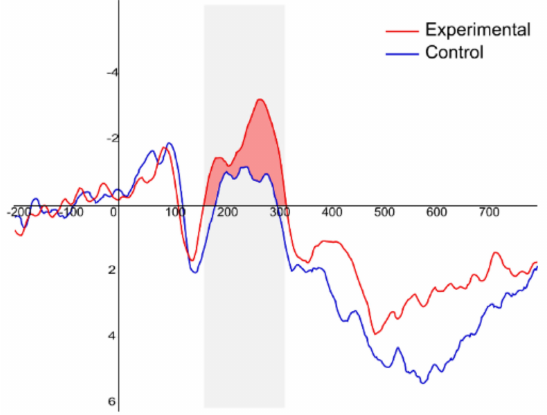
Figure 2. N2 event-related potential recorded during a challenging computerised task tapping into attention and executive control resources. EEG recording channel: Fz. Waveforms based on grand averages of the Control (blue line) and Experimental (red line) groups.